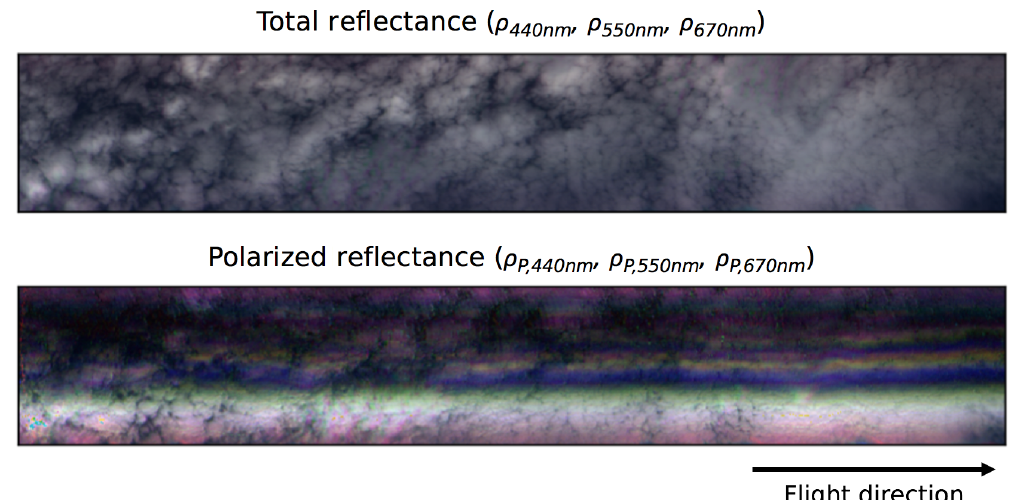
Figure 5. AirHARP data taken at the same time, location, and geometry as Figs. 3 and 4 reveal a heterogenous cloud field in total re- flectance (a) and a cloudbow in polarized reflectance (b) . The linear distribution of cloudbow oscillations is heterogenous compared to the Fig. 4b simulation and reflects the variability in the cloud field. Both images are RGB composites of push brooms from 440, 550, and 670nm view sectors near + 38 ◦ , presented without axes for visual purposes only. A single gridded pixel in this image represents 50m, and the scene stretches approximately 37km along-track by 5km